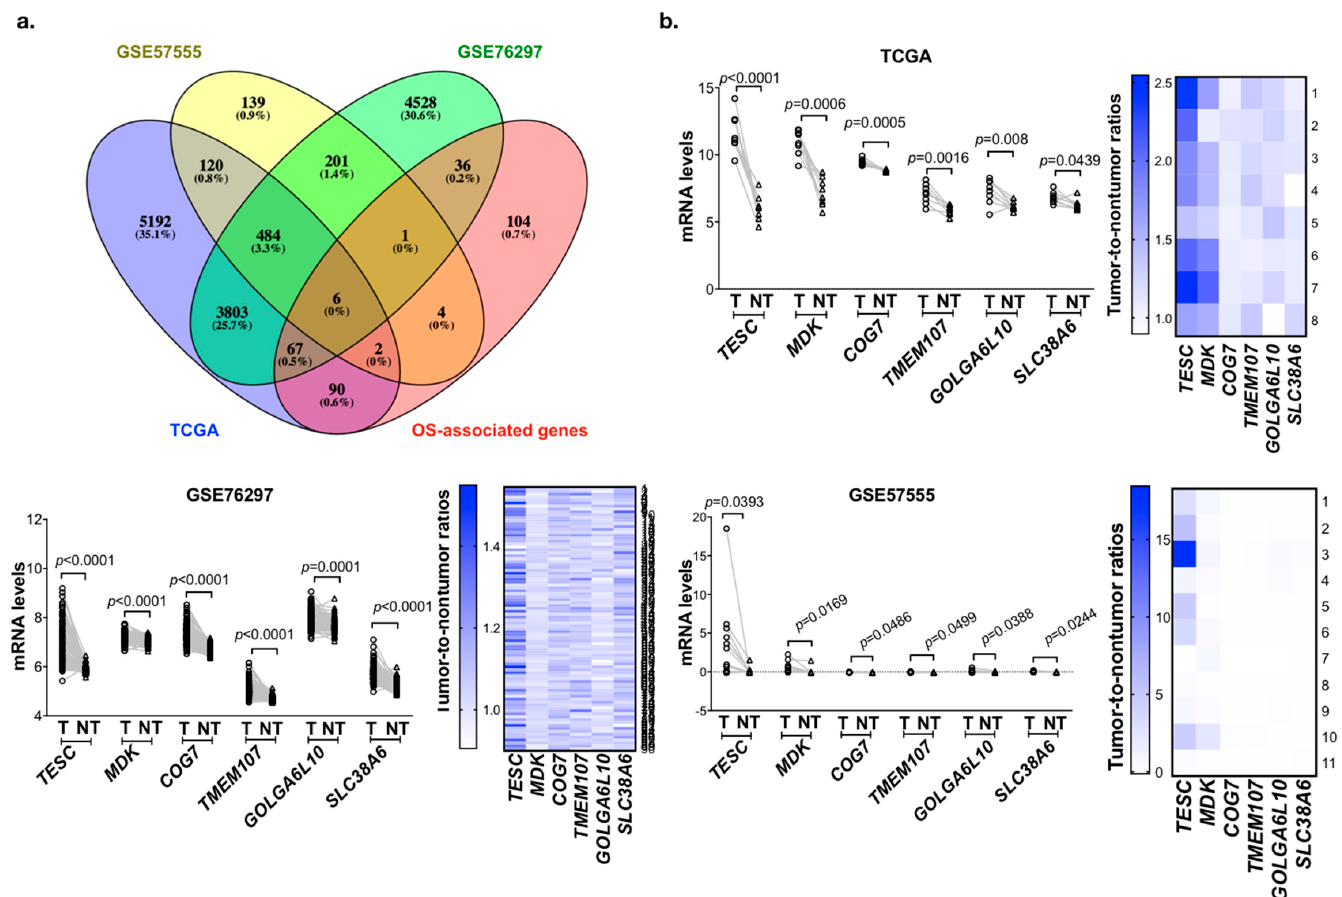
Figure 1. Identification of candidate genes that are upregulated in cholangiocarcinoma and associated with poor survival. ( a ) Venn diagram of overall survival (OS)-associated gene analysis in The Cancer Genome Atlas (TCGA) and differentially expressed genes in the TCGA and Gene Expression Omnibus (GEO) databases. ( b ) Line plots of differential candidate genes transcript expression in paired tumor (T) and matched adjacent non-tumor (NT) tissues from the TCGA (upper), GSE76297 (bottom left,) and GSE57555 (bottom right). Heat map representing tumor-to-non-tumor ratios of candidate genes from TCGA (upper), GSE76297 (bottom left), and GSE57555 (bottom right) datasets. p -values indicate significant differences as determined by the Wilcoxon matched pairs test.